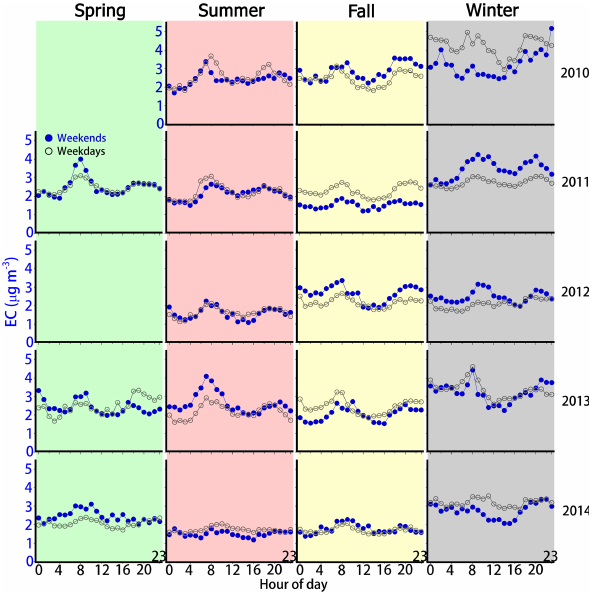
Figure 8. Diurnal variations of EC concentrations during weekdays and weekends over different years in